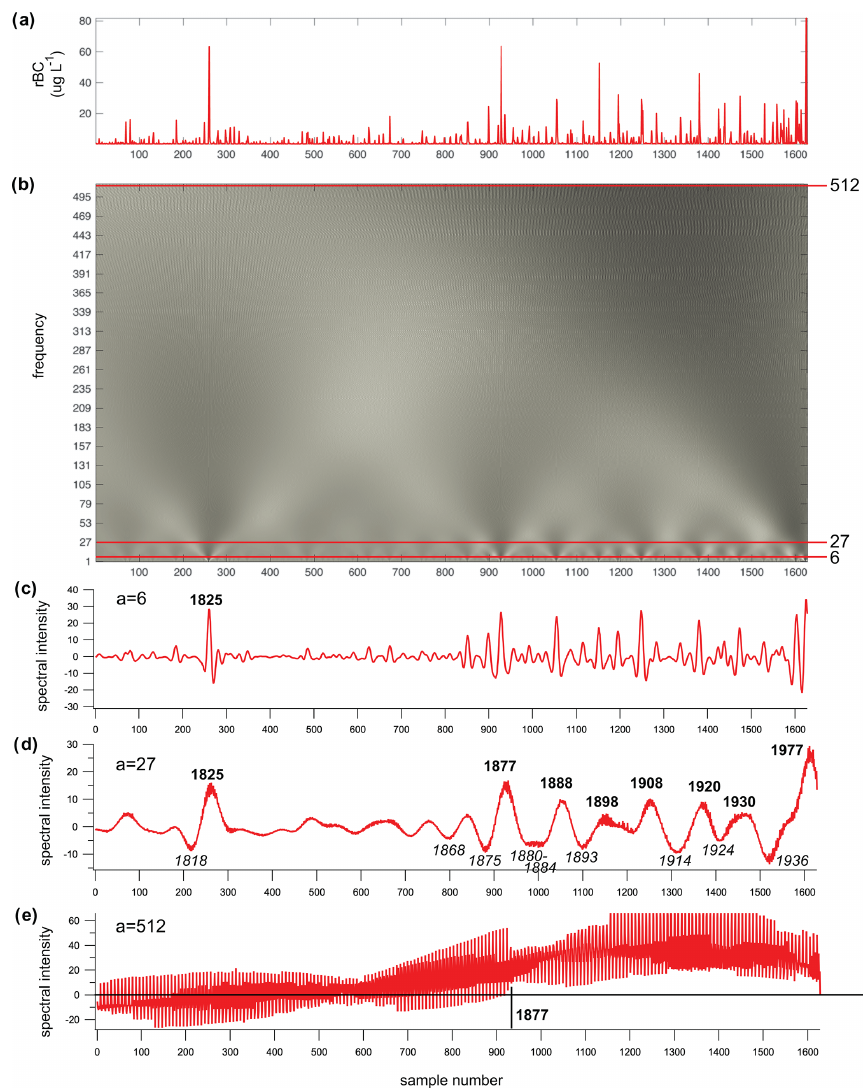
Figure 4. The spectral analysis of the Dasuopu rBC concentration record. Sample number 1 is located at the bottom of the ice core (1781CE), and sample number 1628 is at the top of the firn section (1992CE). (a) The rBC record plotted relative to sample number. (b) The spectral analysis showing variance across all frequency scales relative to sample number ranging from a = 2 to a = 512. Darker shades indicate relatively stronger (more positive) coherence between the wavelet and the rBC record, as indicated in the spectral coefficients. Panels (c–e) are the spectral coefficients relative to sample number for frequency scales a = 6, 27, and 512,